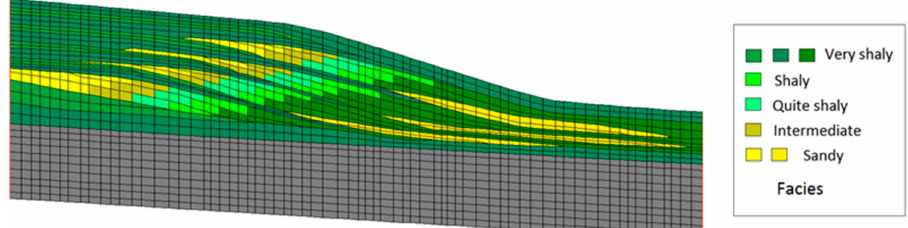
Figure 2. Mesh and lithology distribution of the study-case in the present-day; vertical exaggeration ×